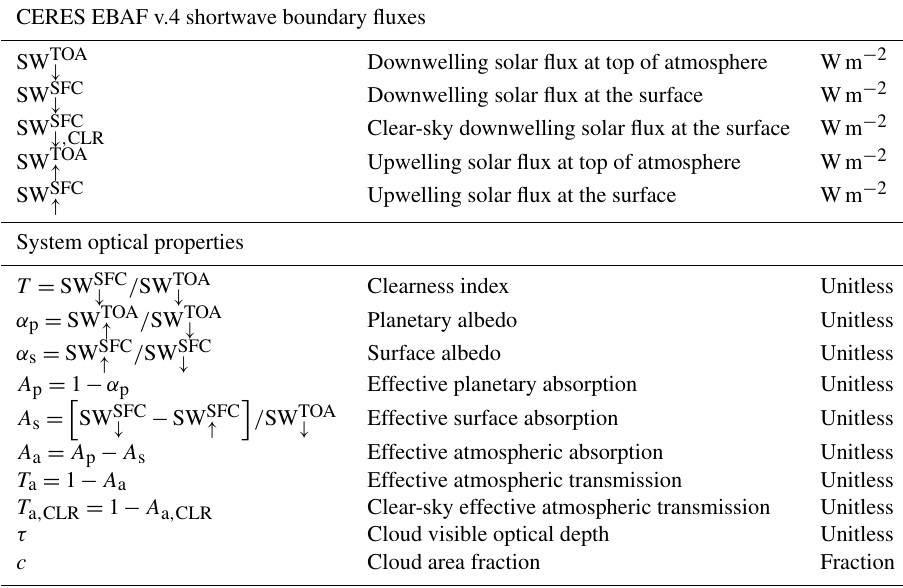
Table 2. Definition of CERES input variables and other system optical properties derived from CERES inputs. All variables have a monthly temporal resolution and a spatial resolution of 1 ◦ × 1 ◦